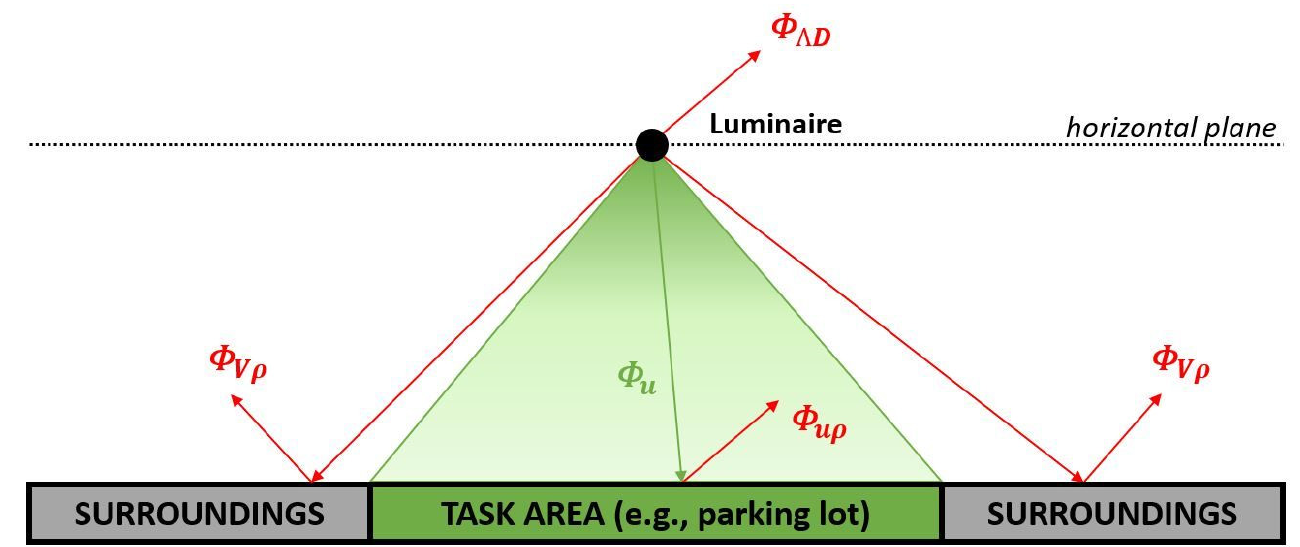
Figure 2. The scheme of the basic and typical situation of outdoor amenity lighting: φ Λ D —luminous flux directly emitted into upper hemisphere, φ u —useful luminous flux, φ u ρ — luminous flux reflected from the task area, and φ V ρ —luminous flux reflected from